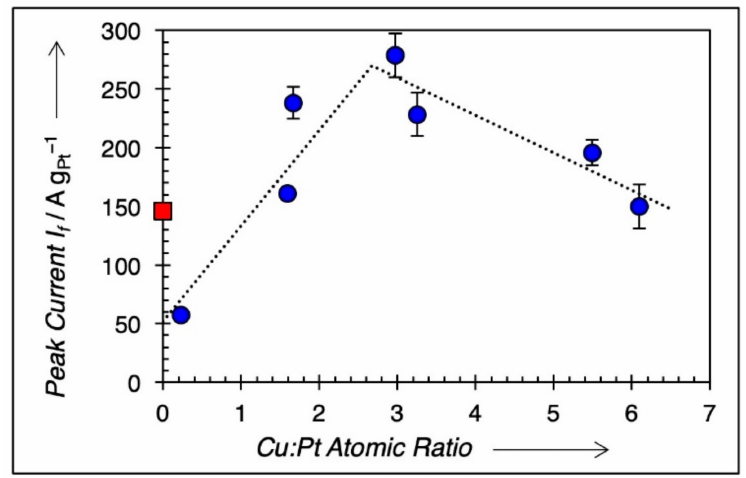
Figure 7. Mass activity of Pd@Cu–Pt/C catalysts prepared by continuous co-ED versus the atomic ratio of Cu and Pt in the shell. Dashed lines are linear regressions of the points to the left and right of peak (peak inclusive), added as a guide to the eye. Red square is a commercial 20 wt % Pt/XC-72 catalyst for